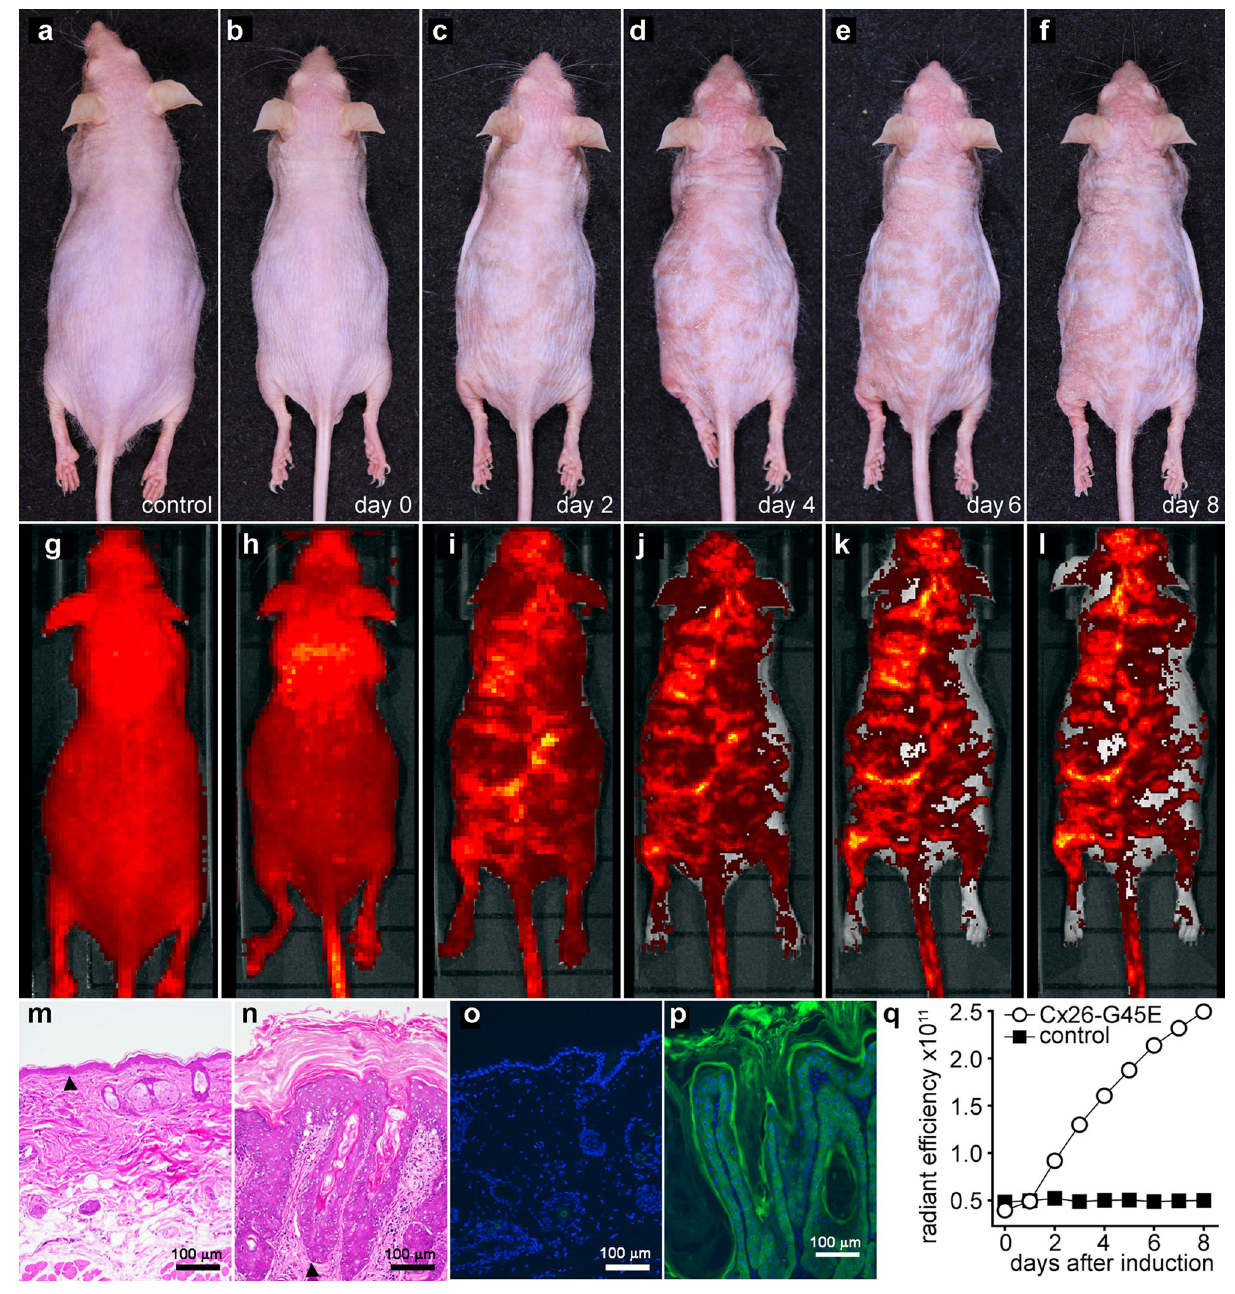
Figure 2. Quantitation of skin disease. ( a ) A wild-type mouse, and ( b ) a Cx26-G45E transgenic mouse had normal skin before doxycycline induction. ( c – f ) KID lesions appeared on the transgenic on day 2, and worsened through day 8 after induction. IVIS imaging showed low background fluorescence in the ( g ) wild-type and ( h ) transgenic animals before induction. ( i – l ) EGFP fluorescence increased for the transgenic from days 2–8. ( m ) Normal epidermis in the control mouse. ( n ) The transgenic displayed KID pathology. ( o ) No EGFP fluorescence was detected in control skin. ( p ) An EGFP signal was observed in the thickened epidermis of the transgenic. ( q ) Plots of the total fluorescent radiant efficiency against the time after doxycycline induction. Black arrowheads mark the epidermal/dermal